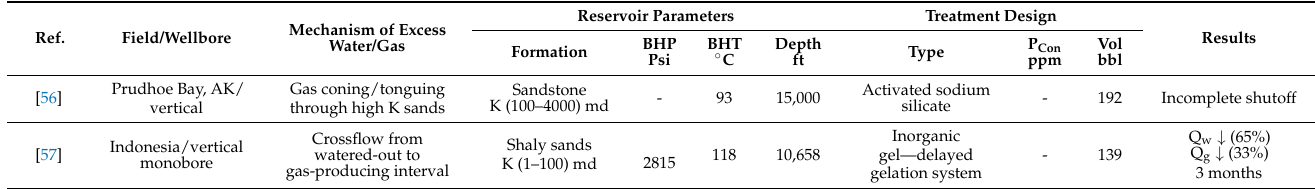
Table 9. Inorganic gel systems—field